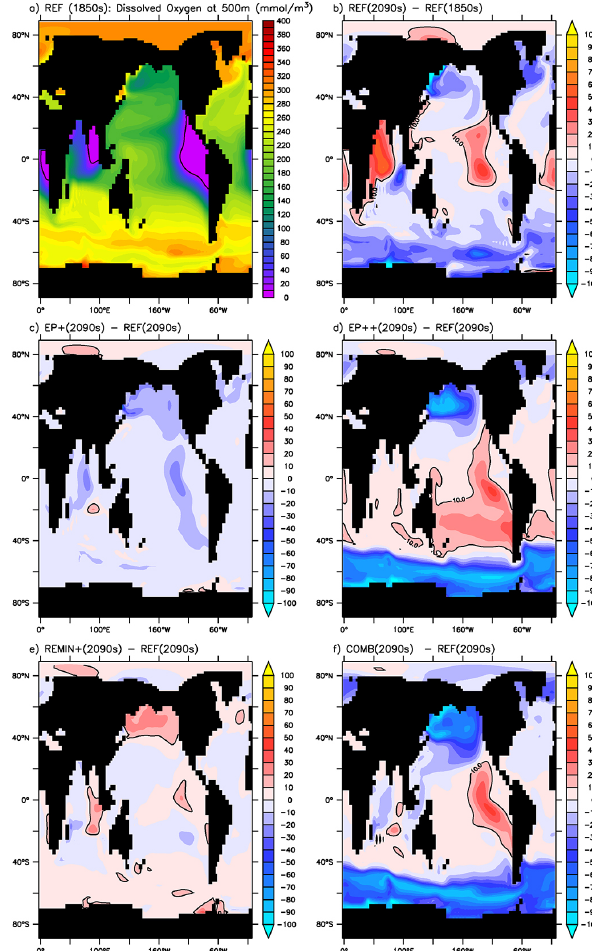
Figure 8. Export production (molCm − 2 yr − 1 ) from the (a) REF in 1850; (b) the change in 2090–99 mean for REF relative to (a) . For the 2090–2099 mean, the change relative to REF for (c) EP+; (d) EP++; (e) REMIN+; (f) COMB simulations.